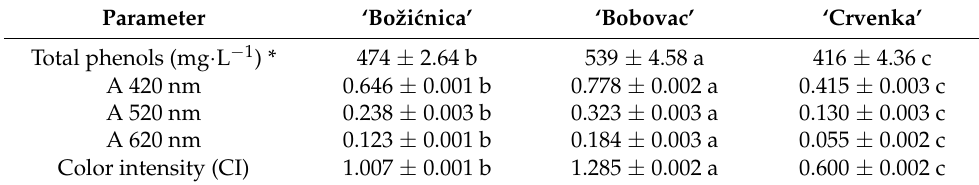
Table 3. Total phenols and color parameters of sparkling ciders.